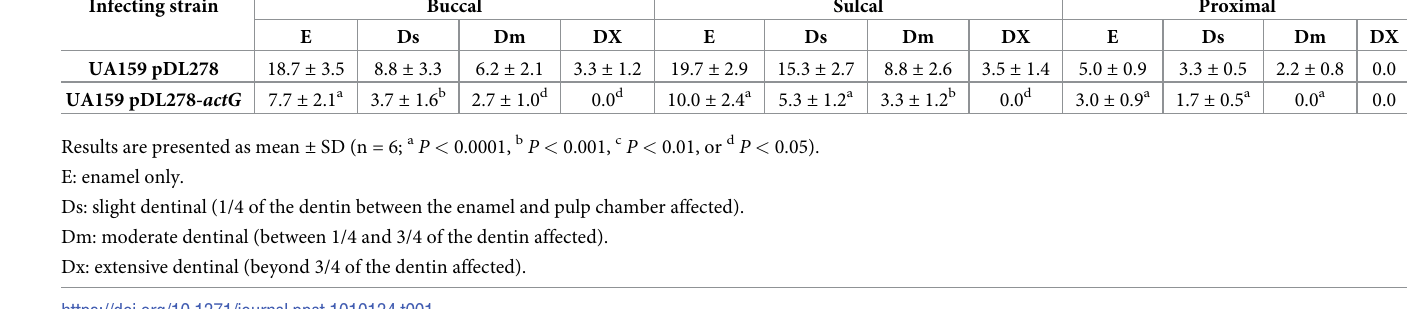
Table 1. Effect of actG on the cariogenicity of S . mutans in rats (Keyes’ score). Infecting strain Buccal